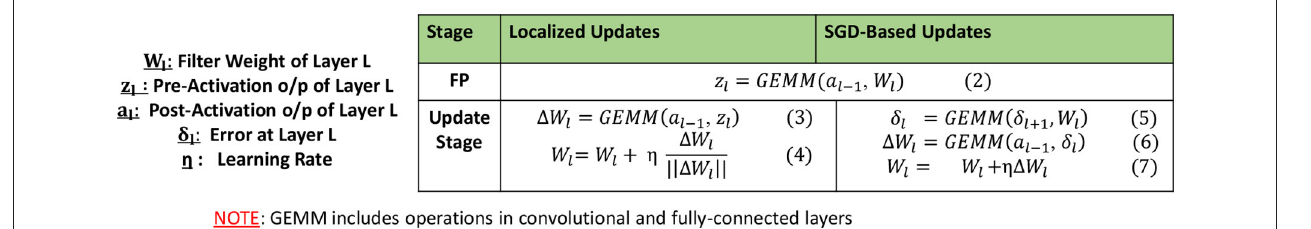
FIGURE 1 | Comparing localized updates and SGD-based BP